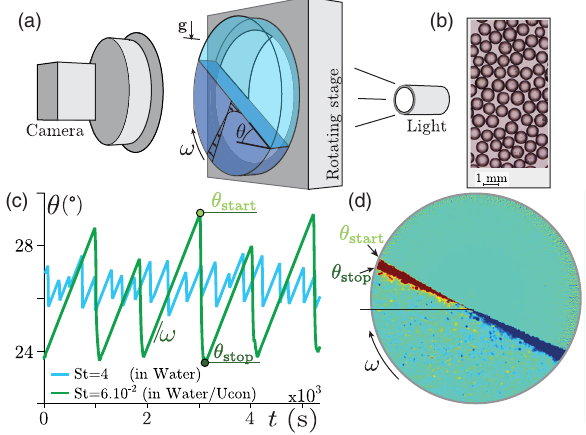
FIG. 1. Evidence of hysteresis in overdamped granular suspen- sions: (a) Sketch of the experimental setup. (b) Picture of the large (c)Angleofavalanche θ versustimeforlargeglassbeadsimmersed in pure water (St ¼ 4 ) or in a mixture of water and Ucon oil (St ¼ 6 × 10 − 2 ); the rotation rate of the drum is ω ¼ 5 × 10 − 3 ° · s − 1 . (d) Difference between two images taken just prior to and after an avalanche